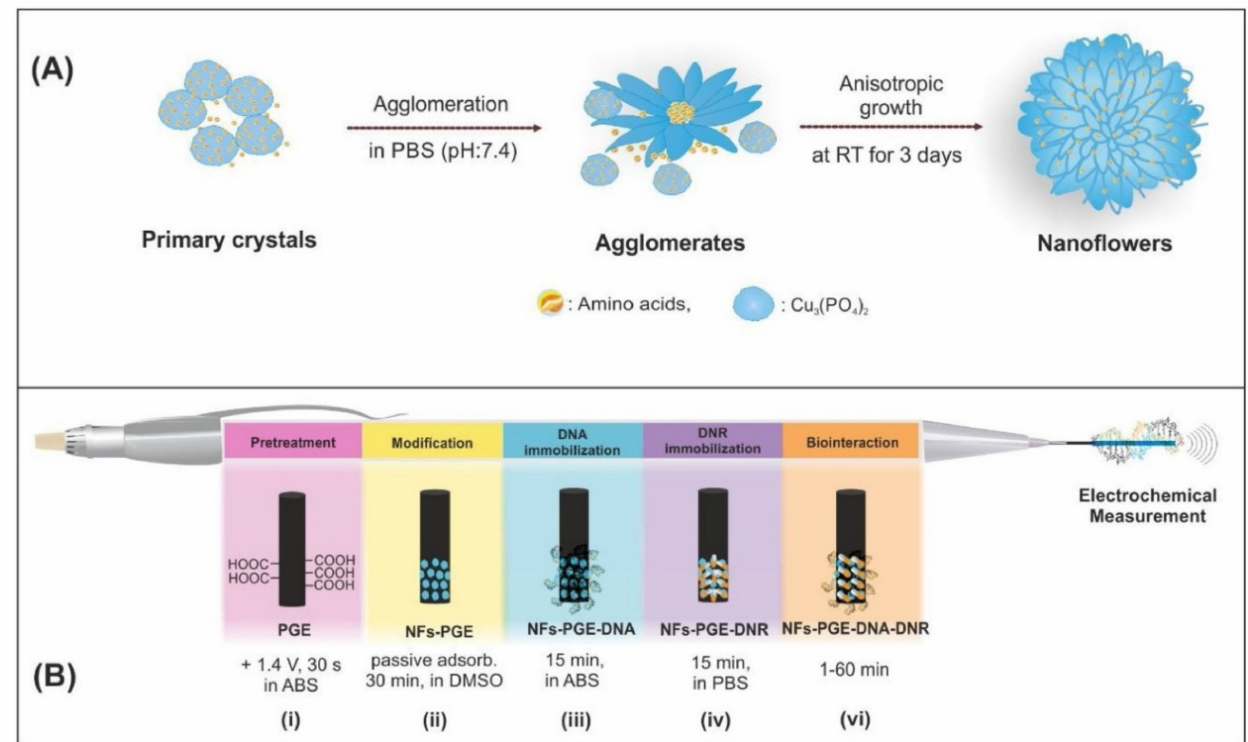
Figure 6. ( A ) Schematic illustration of the formation of amino acids-Cu 3 (PO 4 ) 2 hybrid NFs, ( B ) The representative scheme of the pretreatment of PGE (i), modification of NFs (ii), immobilization of DNA (iii) and DNR (iv), surface-confined interaction of DNR and ctdsDNA (vi). Figure adapted from the reference [53] with permission from